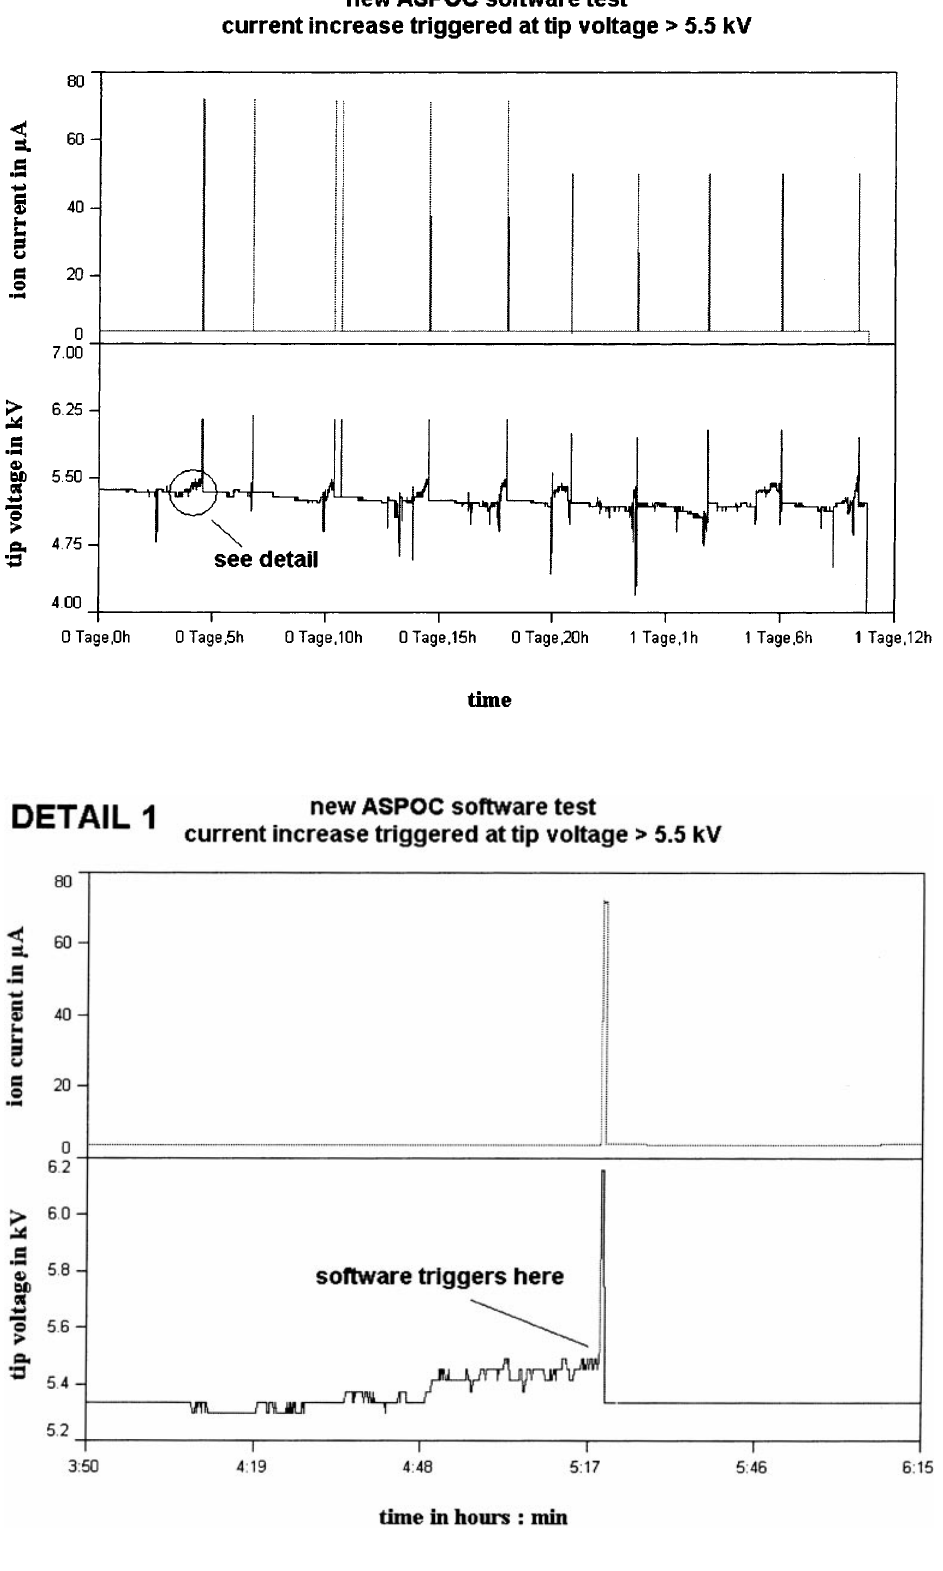
interval 11:15 to 11:45 UT are shown in Fig. 6. During that time Equator-S was moving inbound from 8.1 to geocentric distance at (cid:25) 11 h LT, a location 3 to 7.5 R E 3.5 R inside the nominal magnetopause. The preceding E